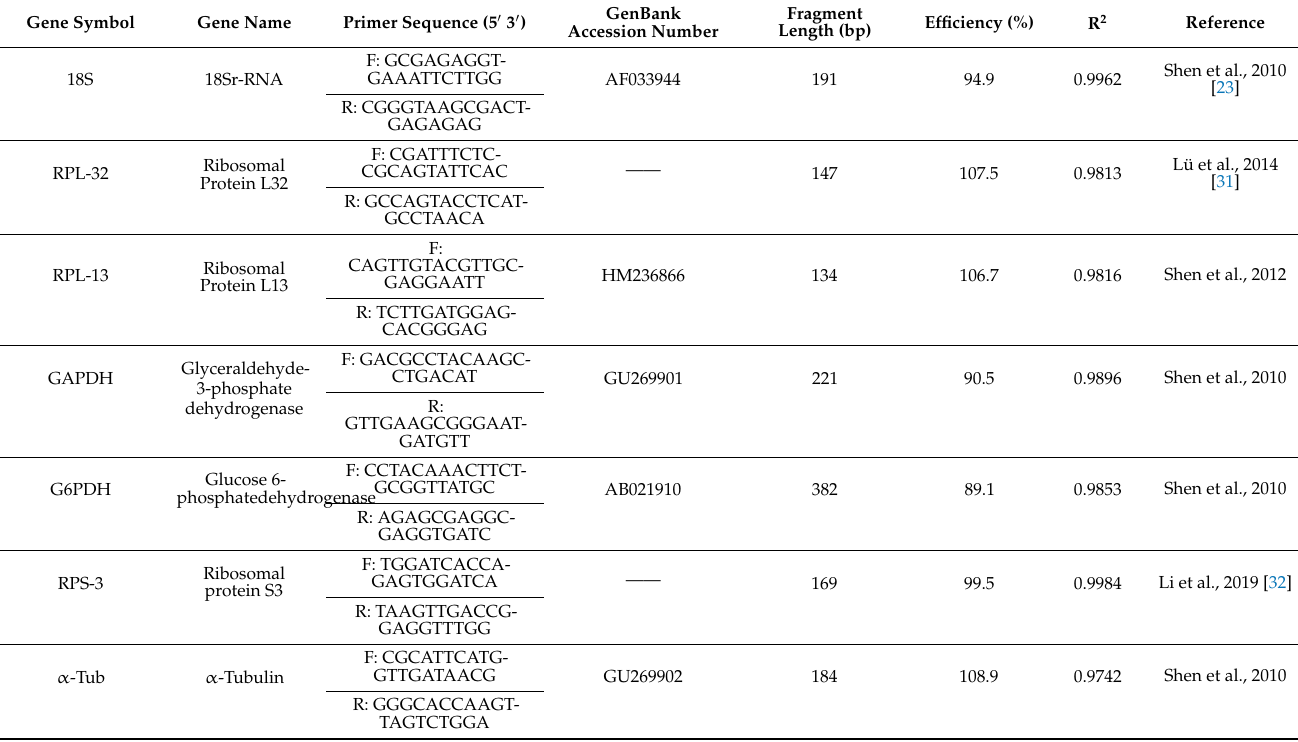
Table 1. Primer sequences for seven reference genes used in the RT-qPCR analysis (R 2 , regression coefficient; F, forward primer; R, reverse